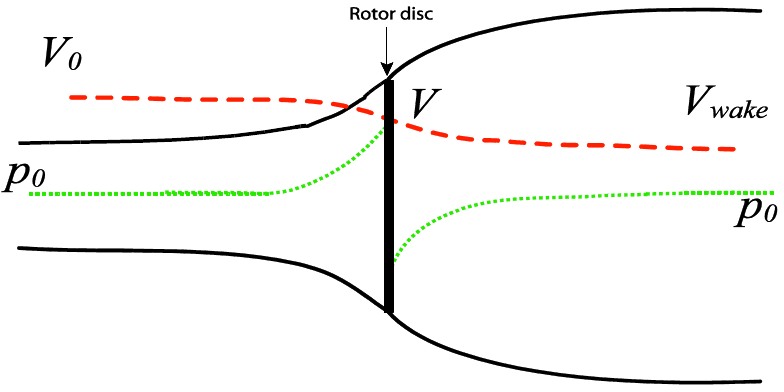
Figure 7. Schematic of wind speed and pressure as air flows through a wind turbine rotor.